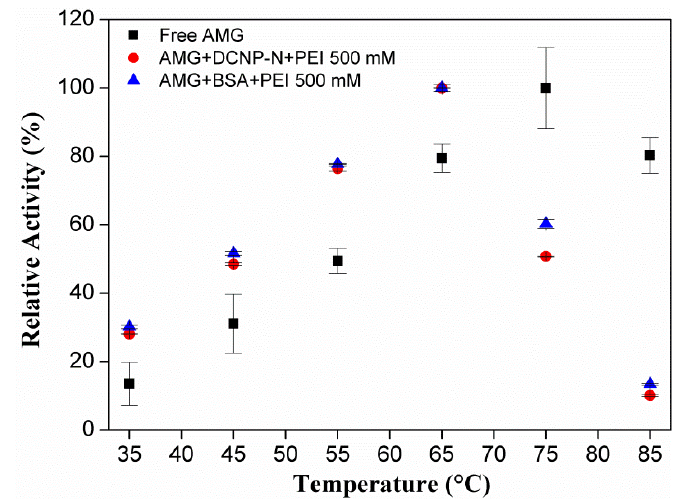
Figure 13. Effect of the temperature on the activity of free amyloglucosidase (AMG) and AMG CLEAs prepared by enzyme treatment with polyethyleneimine (PEI) and co-aggregation with the magnetic nanoparticles DCNP-N or bovine serum albumin (BSA). Activity assays conditions: 1% ( w / v ) dextrin solution in 50 mM sodium citrate buffer pH 4.5, 10 min reaction under 900 rpm stirring. Values are shown as the mean of triplicate experiments ± s.d.